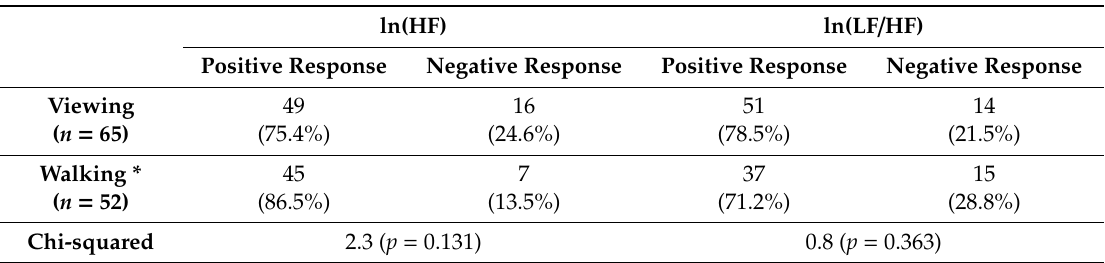
Table 3. Numbers and proportions of participants who showed positive and negative responses in heart rate variability indices during walking in and viewing forests. ln(HF)